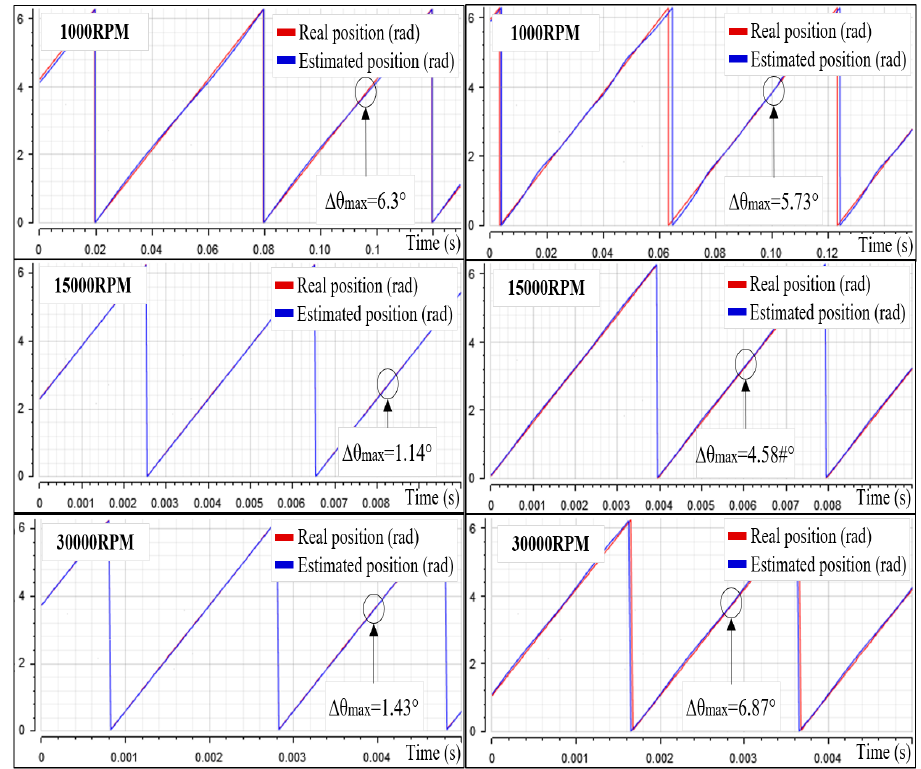
Figure 21. Rotor position estimates in healthy ( left ) and Open phase A ( right ) conditions for different speeds.